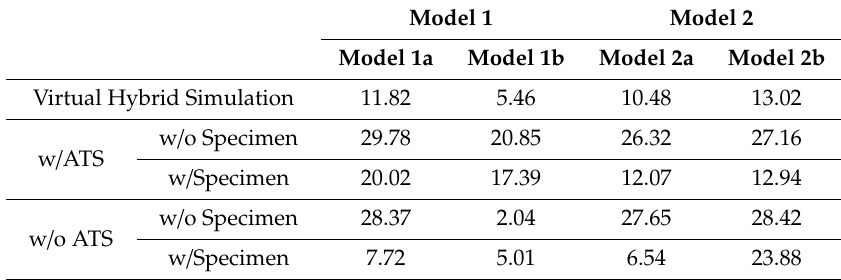
Table 2. NRMSE (%) for brace displacement predictions where ‘last’ force input dimension is updated in RTHS